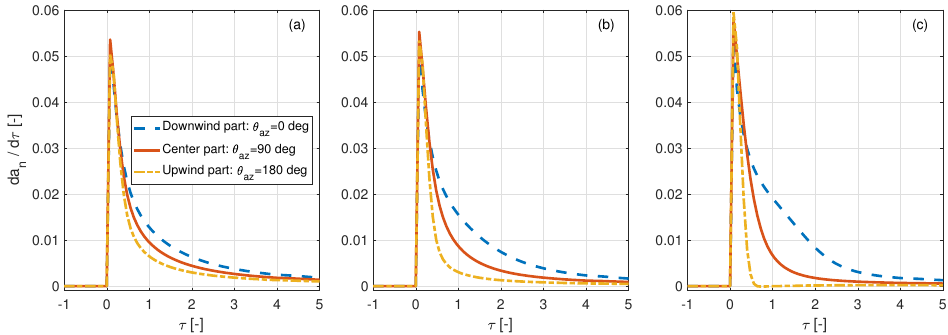
Figure 9. Time derivative of a n at different azimuth angles from CFD model when base C T = 0.6, step ∆ C T = +0.1, r/D = 0.4, ( a )